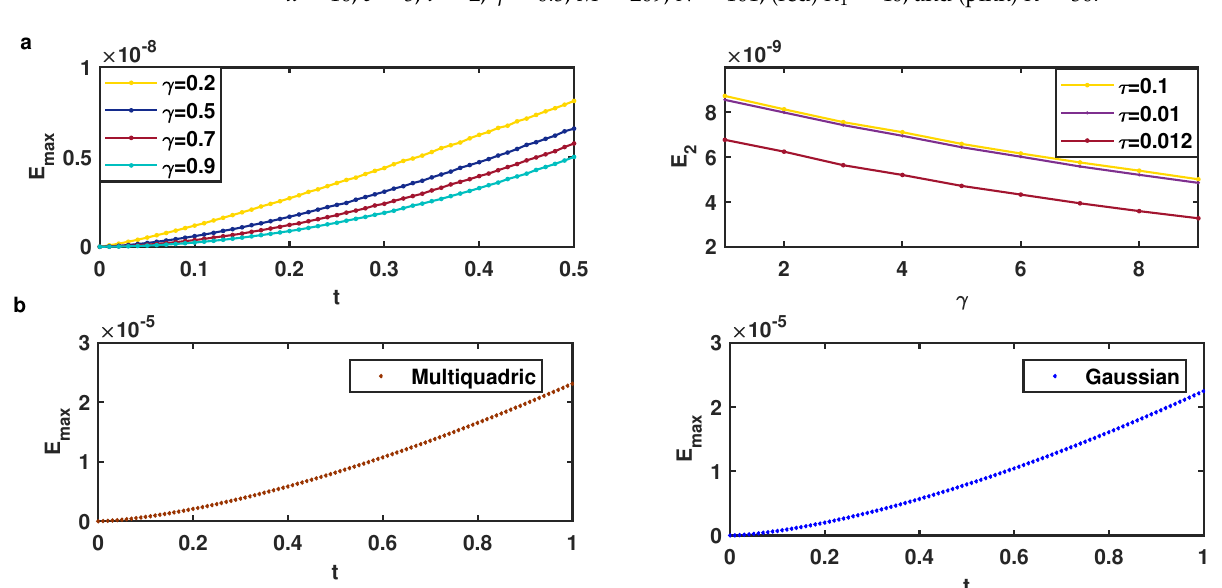
Figure 6. E max and E 2 and the effect of the fractional order in time for Example 2, where ( a ) T = 0.5, α = 10, c = 5, ν = 2, K = 120, K 1 = 90, M = 128, N = 96, and ( b ) τ =